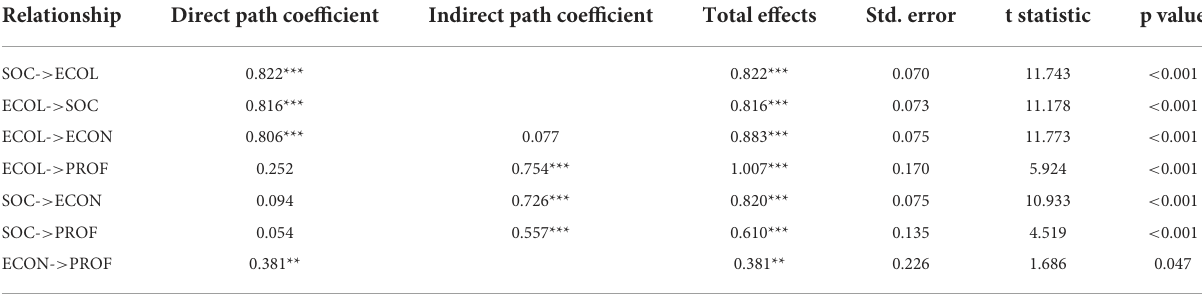
TABLE 6 Total, direct, and indirect effects of the path models.